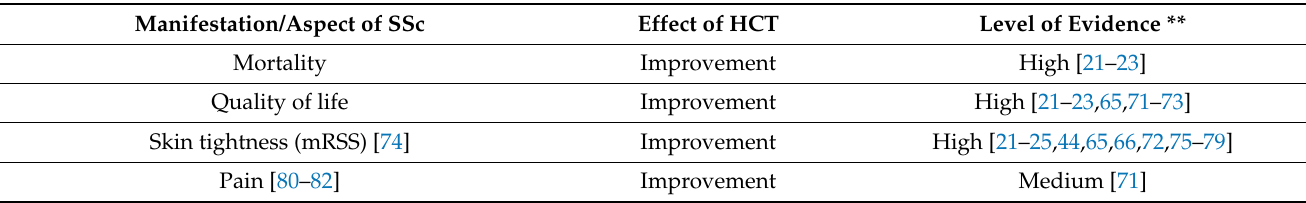
Table 1. Effects of HCT on multiple manifestations/aspects of SSc